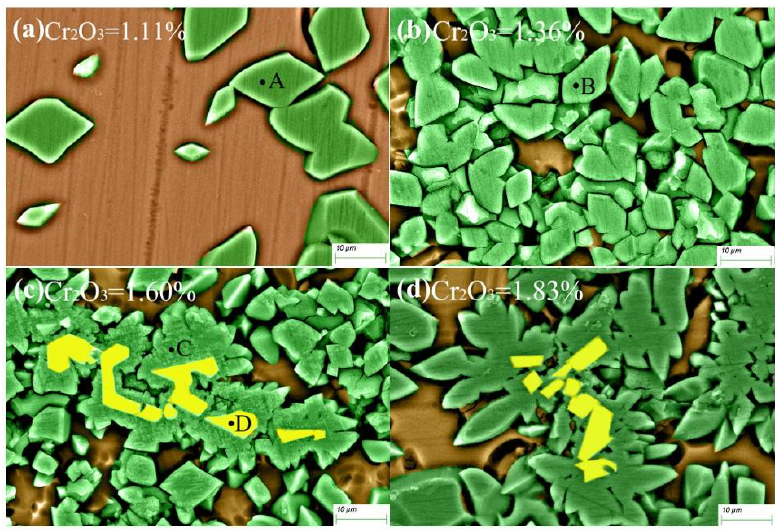
Figure 7. SEM photos of glass – ceramics samples #1~#4 (The mass fraction of Cr 2 O 3 in ( a – d ) is 1.11%, 1.36%, 1.60%, and 1.83%).